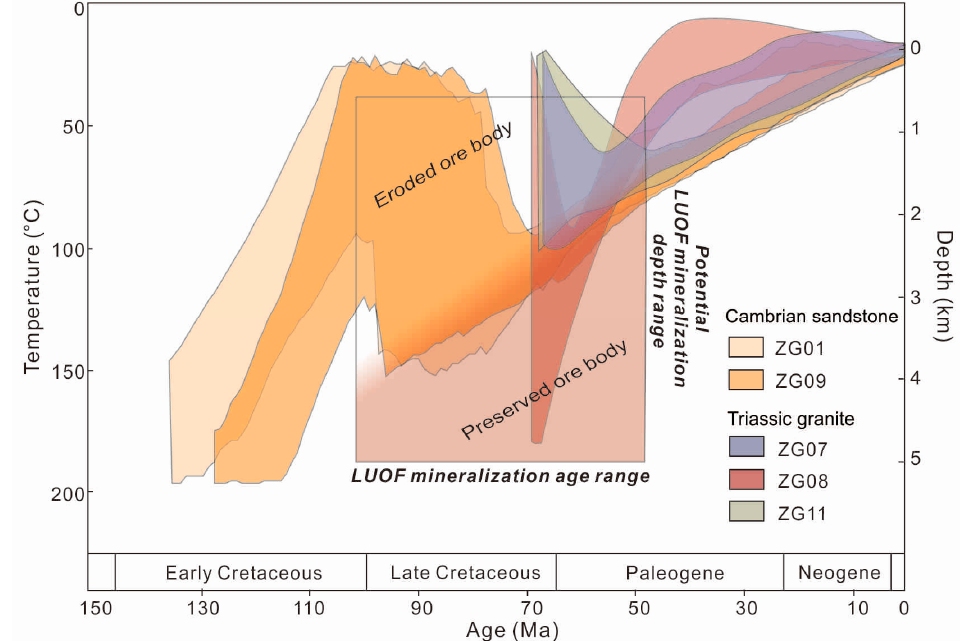
Figure 7. Cretaceous–Recent time–temperature (t-T) path envelopes consistent with low-temperature thermochronology data from the Lujing uranium ore field (LUOF) presented herein overlain by the time–temperature window of LUOF U mineralization [3,10,11]. LUOF uranium mineralization pressures of 152–507 bars [10] allow for possible ore formation depths between ~0.6 and ~5 km, depending on whether paleo-pressure conditions were more akin to lithostatic (100 bars/km) or hydrostatic (250 bars/km) [3]. Thermal history models were generated using QTQt [49] following the modeling protocol described in Section 3. Only inverse thermal history models of samples that also yielded AFT data are presented here, as they are better constrained. The t-T path envelopes suggest that the LUOF experienced a phase of pronounced denudational cooling commencing in the latest Late Cretaceous to early Paleogene (~75–50 Ma) from between ~180 and 60 ◦ C, followed by continual cooling to surface temperatures by the present day. This is consistent with the removal of a maximum ~1.2–4.8 km of section (assuming a paleo-geothermal gradient of 33 ◦ C/km [81]). However, the thickness of removed overburden may be less due to any thermal blanketing effect that may have accompanied sedimentation [73]. As a result of regional denudation, a moderate to significant portion of the LUOF ore body was likely removed, with the degree of preservation dependent upon the exact timing and pressure conditions (and hence depth) of U-mineralization with respect to the onset of Late Cretaceous–early Paleogene